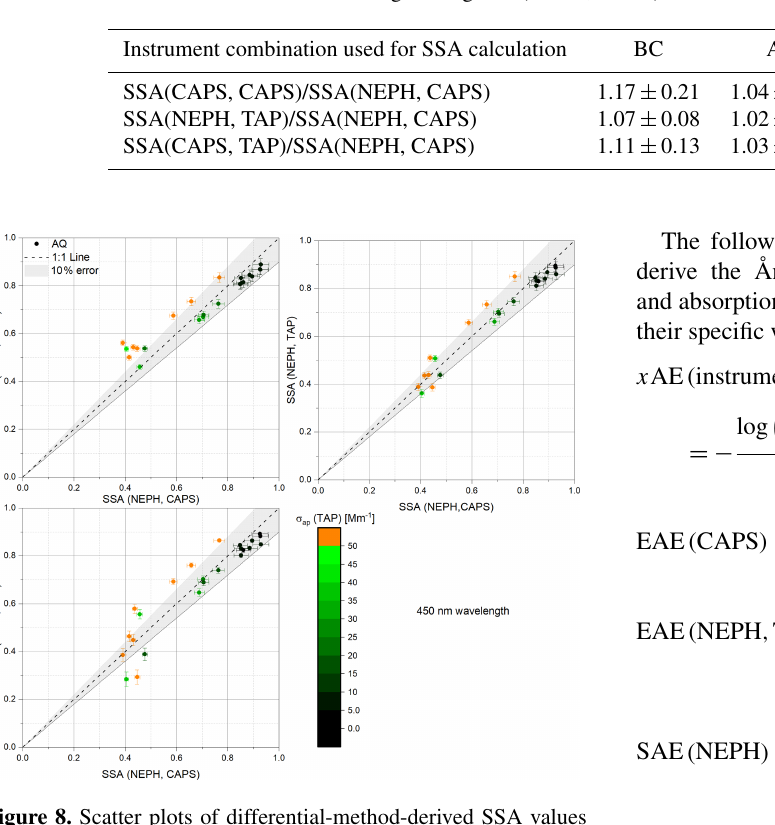
Figure 8. Scatter plots of differential-method-derived SSA values for different instrument combinations at 450nm wavelength using AQ–AS mixtures versus SSA(NEPH, CAPS). The colour code in- dicates σ ap (TAP) values shown in inverse megametres (Mm − 1